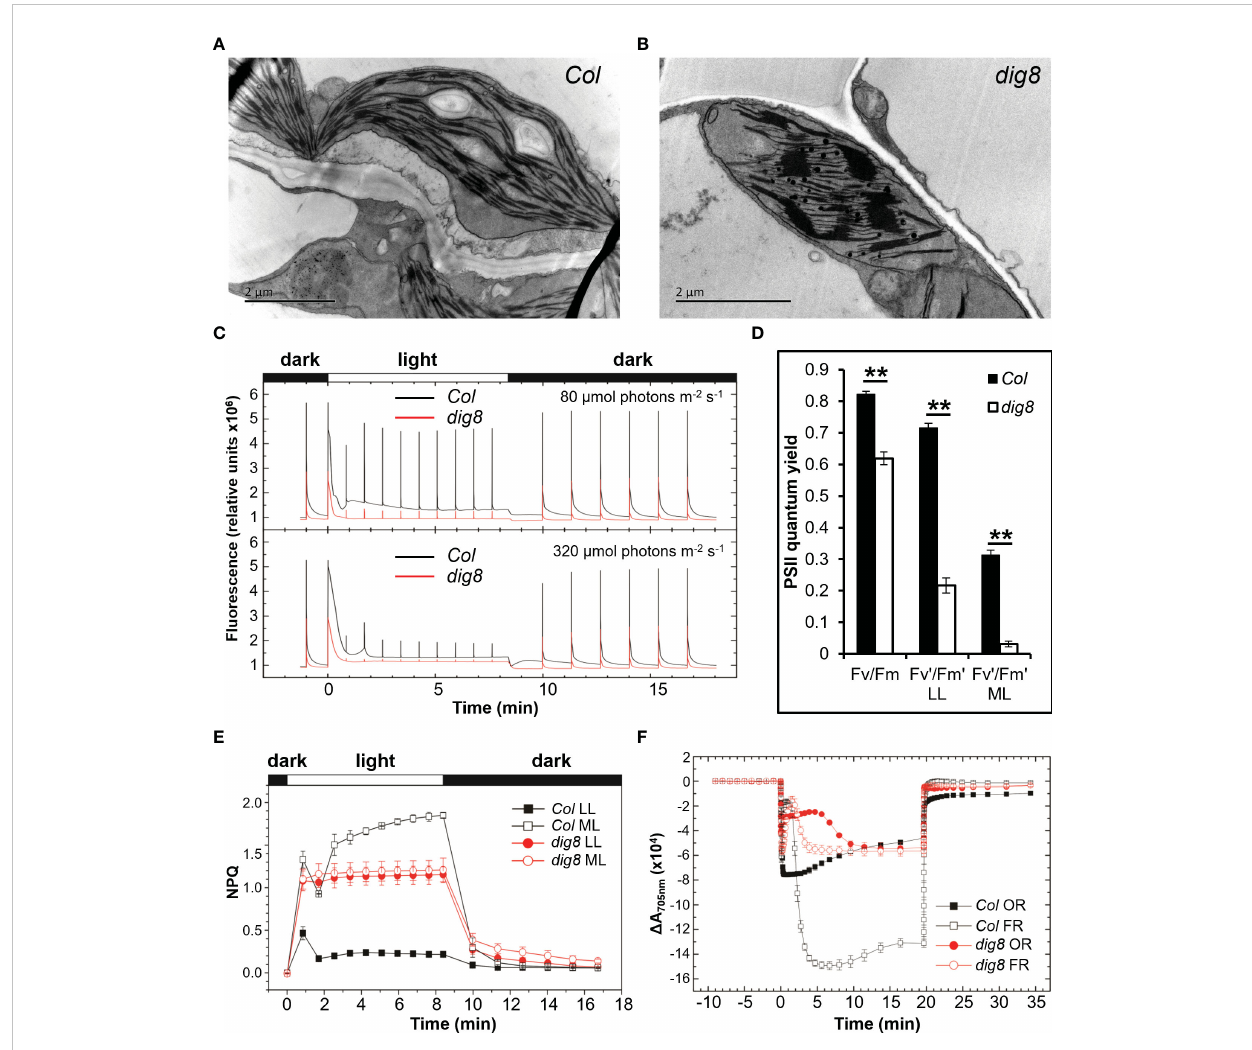
FIGURE 5 The dig8 mutation causes aberrant grana structure in chloroplasts. A and B, images of transmission electron microscopy of grana structures in leaf chloroplasts of Col (A) and dig8 mutant (B) . Scale bar, 2 m m. (C) , Fluorescence of Col and dig8 mutant measured by a Joliot-type spectrophotometer. Leaves of Col and dig8 mutant were dark-adapted for 15 min, illuminated with either low (80 m mol photons m -2 s -1 ) or medium (320 m mol photons m -2 s -1 ) orange actinic light (630 nm), and allowed to recover in darkness. Saturating pulses (7,900 m mol photons m -2 s -1 , 200 ms duration) were applied to measure maximum fl uorescence Fm and Fm ’ . (D) , maximum PSII quantum yield of Col and dig8 mutant in darkness and light. Darkness adapted Arabidopsis leaves were exposed to different intensities of actinic light followed by recovery in darkness. Maximum quantum yield of PSII was calculated. LL: 80 m mol photons m -2 s -1 , ML: 320 m mol photons m -2 s -1 . **P < 0.01 (Student ’ s t test). (E) , Chlorophyll a fl uorescence quenching of Col and dig8 mutant. Leaves of Col and dig8 mutant were darkness-adapted for 15 min. NPQ was induced by 500 s